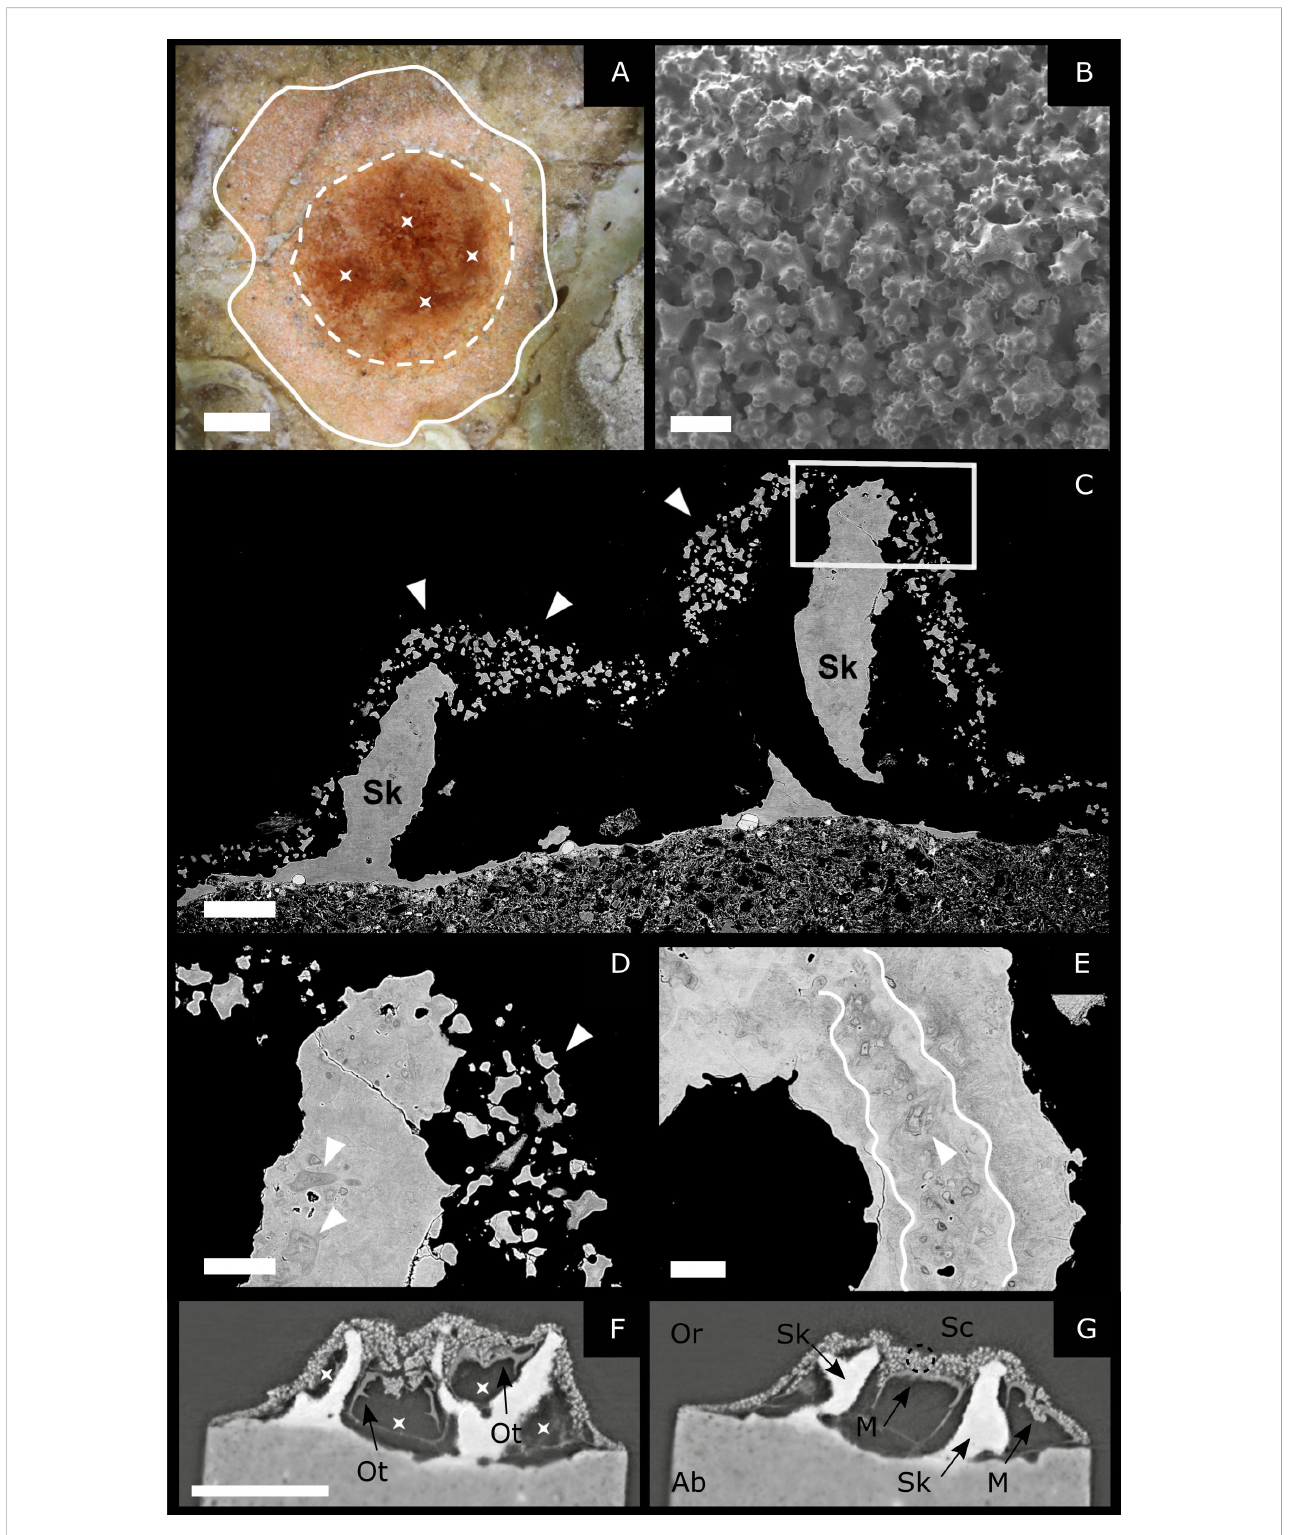
FIGURE 4 2-year-old samples. (A) Stereomicroscope image: asterisks indicate the four footprints left by the polyps. The white dashed lines indicate the central portion of the colony, where the polyps lay. The white, continuous line indicates the area around the colony base, where sclerites diffuse (scale bar 0.5 mm). (B) Scanning electron microscopy: SE mode. On the external surface of the colony, the sample appears like a pile of sclerites (scale bar 50 µm). (C – E) Scanning electron microscopy: BSE mode on polished samples. (C) Longitudinal section of a colony. It is possible to observe the emerging axial skeleton (Sk) and, around it, sclerites (white arrows) enclosed in the living tissues (scale bar 200 µm). (D) Enlargement of C displaying sclerites within the rising skeleton and free sclerites (white arrows) (scale bar 80 µm). (E) Transversal section showing geometrically complex layering (white line) and sclerites embedded in the axial skeleton (white arrows) (scale bar 60 µm). (F, G) Micro-X-ray tomography of a 2-year-old settler. The different images represent two sections of the same sample obtained by processing the 3D images acquired with the tomography. (F) The voids represent the cavities previously occupied by the polyps (indicated by asterisks) and their organic tissues (Ot: Organic tissue). (G) It is possible to observe the axial skeleton (the homogenous white structure, Sk) and the sclerites (the white spots indicated by a dotted circle, Sc) distributed around it. M, mouth; Or, oral; Ab, aboral (scale bar: 1